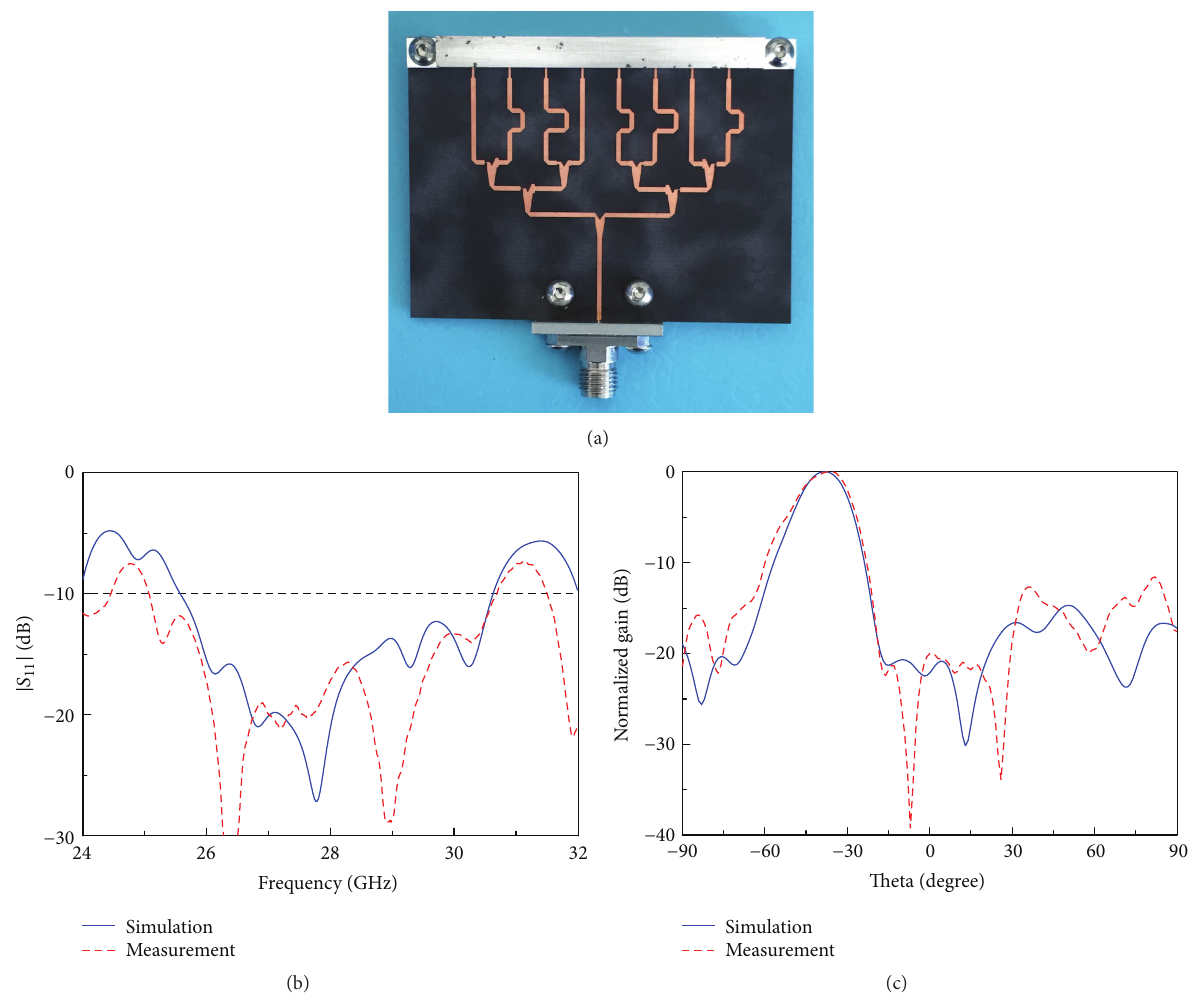
Figure 9: (a) Fabricated sample of the eight-element array with 40 ∘ scan angle; its simulation and measurement (b) |𝑆 11 | values and (c) normalized 28 GHz pattern in 𝐸